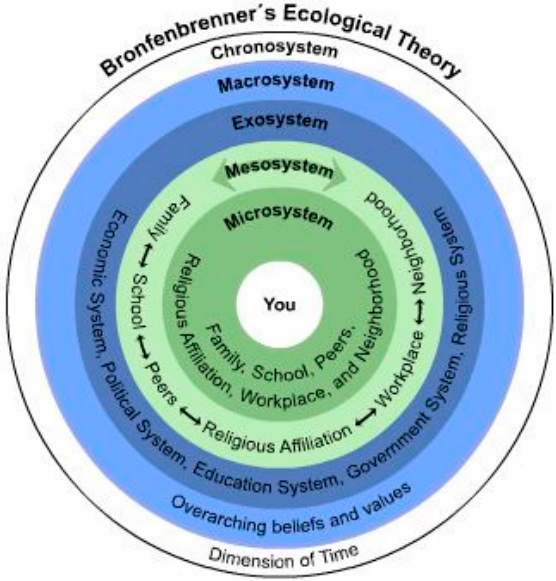
Figure 2. Bronfenbrenners Ecological Model. From Nielsen, J.N. (2011) [36].